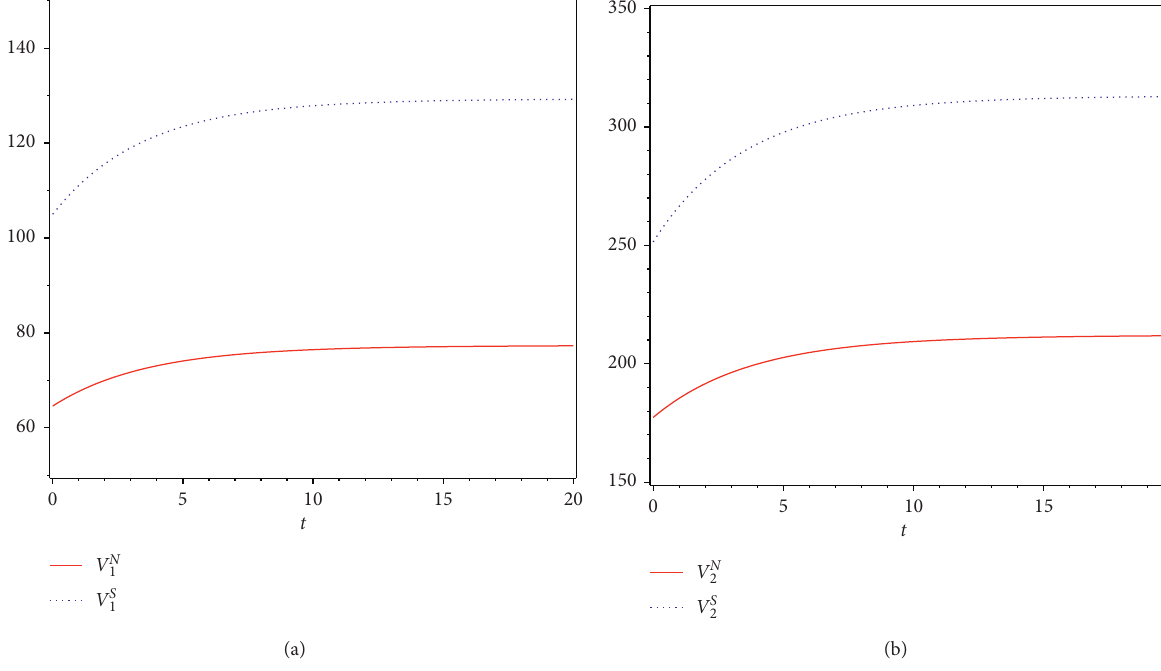
Figure 2: (a) Revenue of the university and (b) revenue of the enterprise under the Stackelberg and Nash game mode.